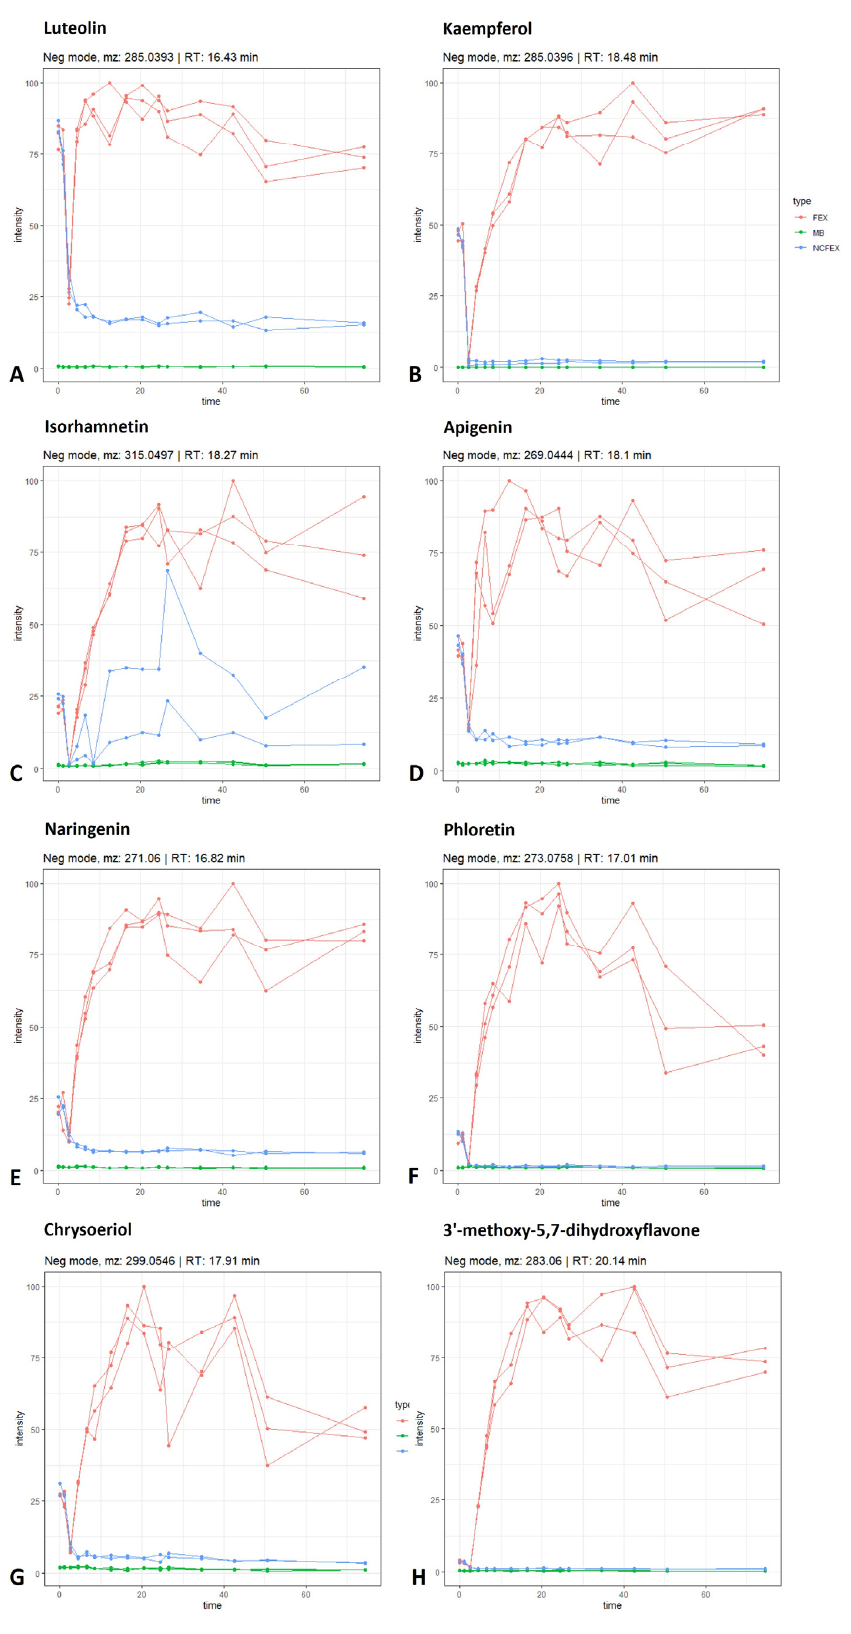
Figure 5. Time profile (time in hours) of luteolin ( A ), kaempferol ( B ), isorhamnetin ( C ), apigenin ( D ), naringenin ( E ), phloretin ( F ), chrysoeriol ( G ) and 3 ′ -methoxy-5,7-dihydroxyflavone ( H ) during gastrointestinal biotransformation. See also legend of Figure 2.